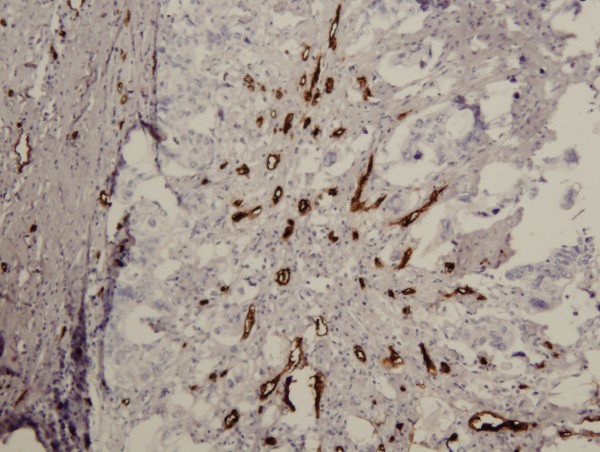
The "hot spot" (original magnification ×10). MVD is 133 microvessel/mm2.